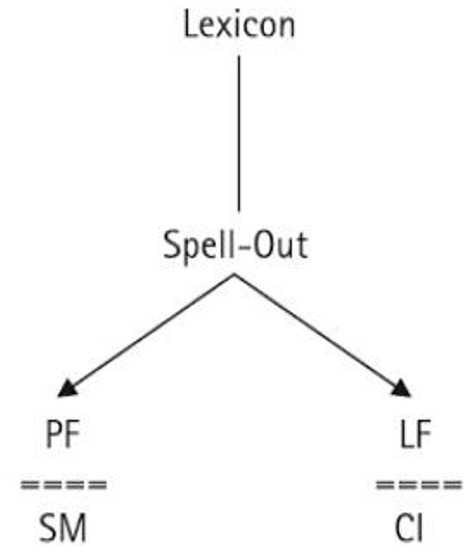
A minimalist architecture of the grammar (Tsimpli et al., 2017a, p. 494).